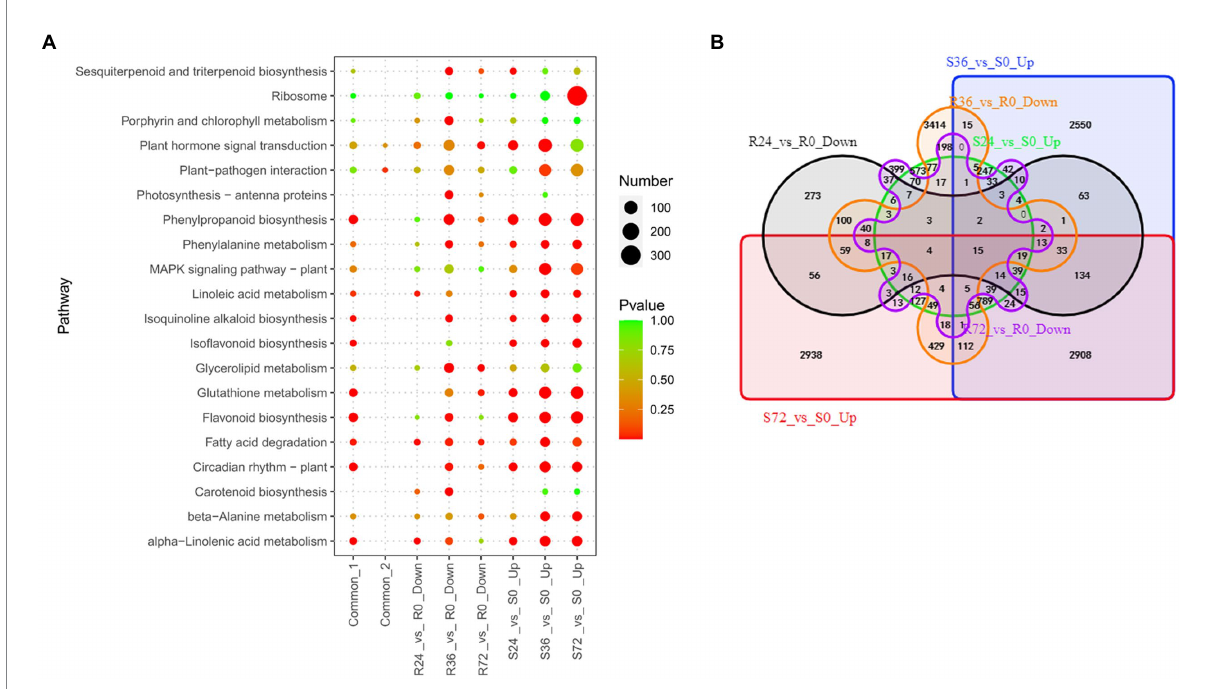
FIGURE 4 Identification of susceptibility-response DEGs in R24 vs. R0, R36 vs. R0, R72 vs. R0, S24 vs. S0, S36 vs. S0, and S72 vs. S0. (A) KEGG enrichment analysis of common, up-regulated, and down-regulated DEGs in each treatment comparison. Common-1 indicates the common up-regulated DEGs in S24 vs. S0, S36 vs. S0, and S72 vs. S0. Common-2 is the common down-regulated DEGs in R24 vs. R0, R36 vs. R0, and R72 vs. R0. (B) A big Venn diagram of DEGs for up-regulated DEGs in Ss vs. S0 and down-regulated DEGs in Rs vs.